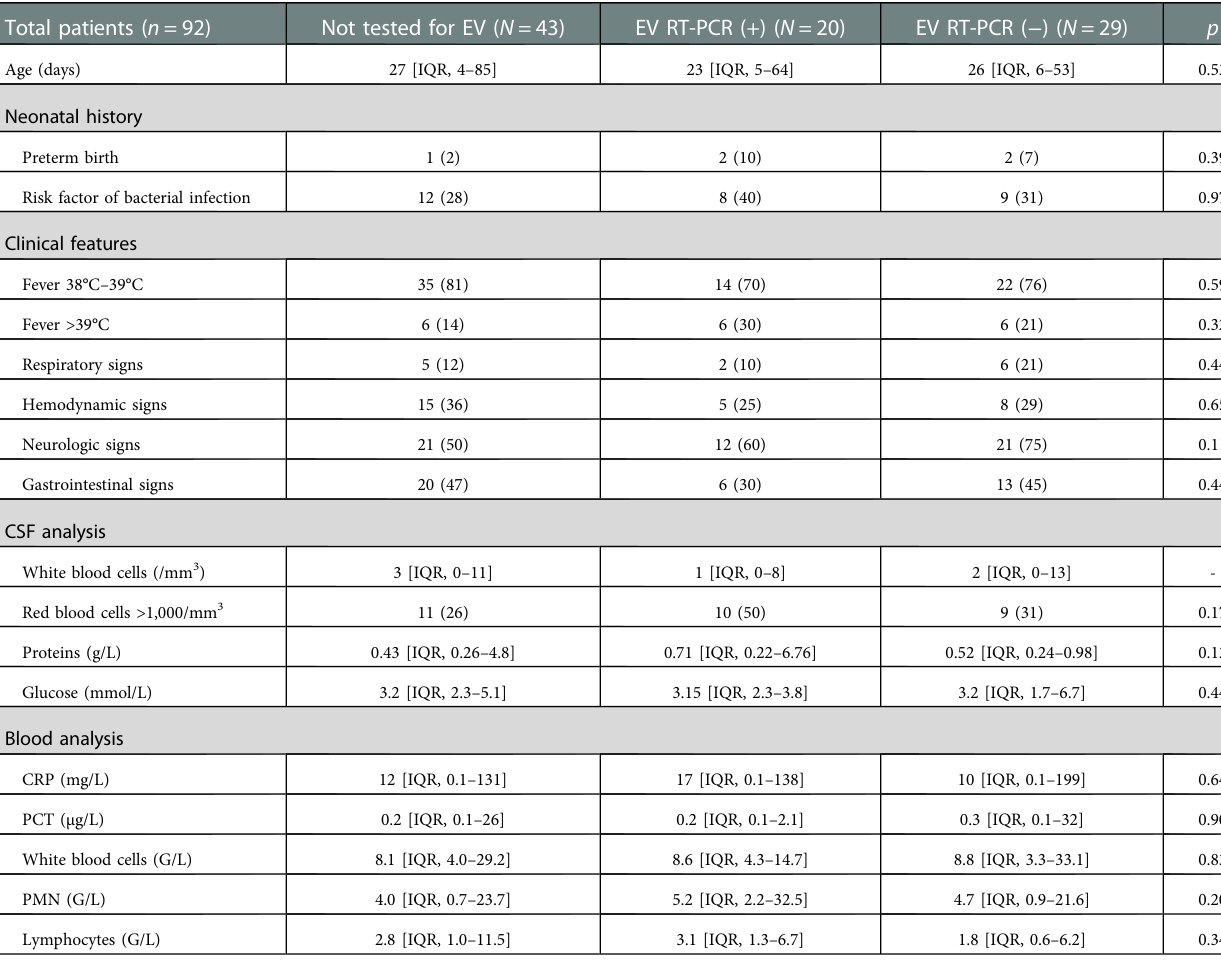
TABLE 1 Clinical and biological features according to EV RT-PCR status in children without pleocytosis. Total patients ( n =